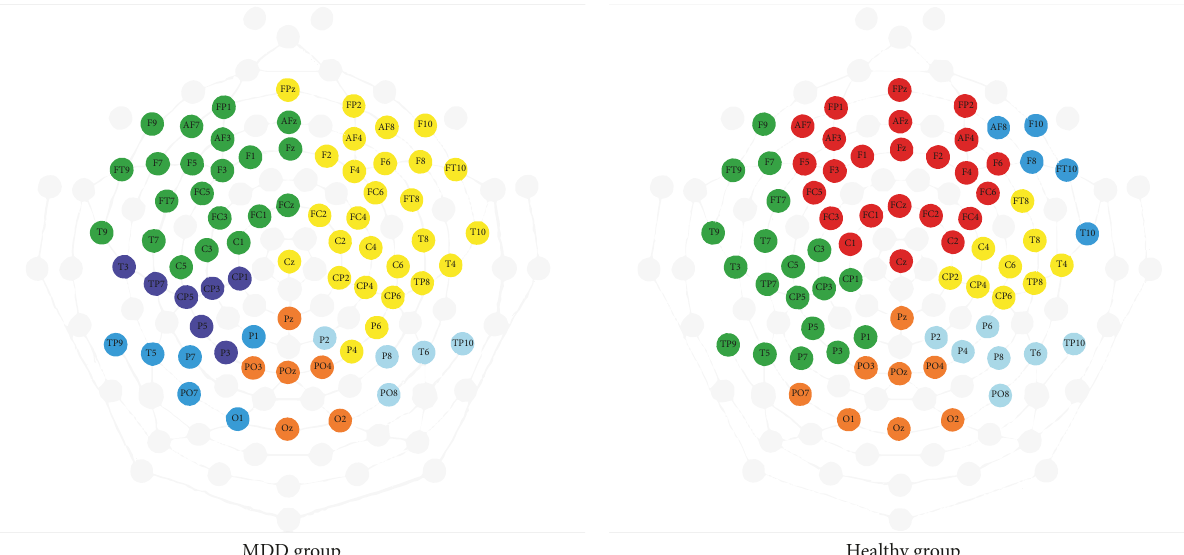
Figure 6: The distribution of the hierarchical clustering graphs under the condition of six